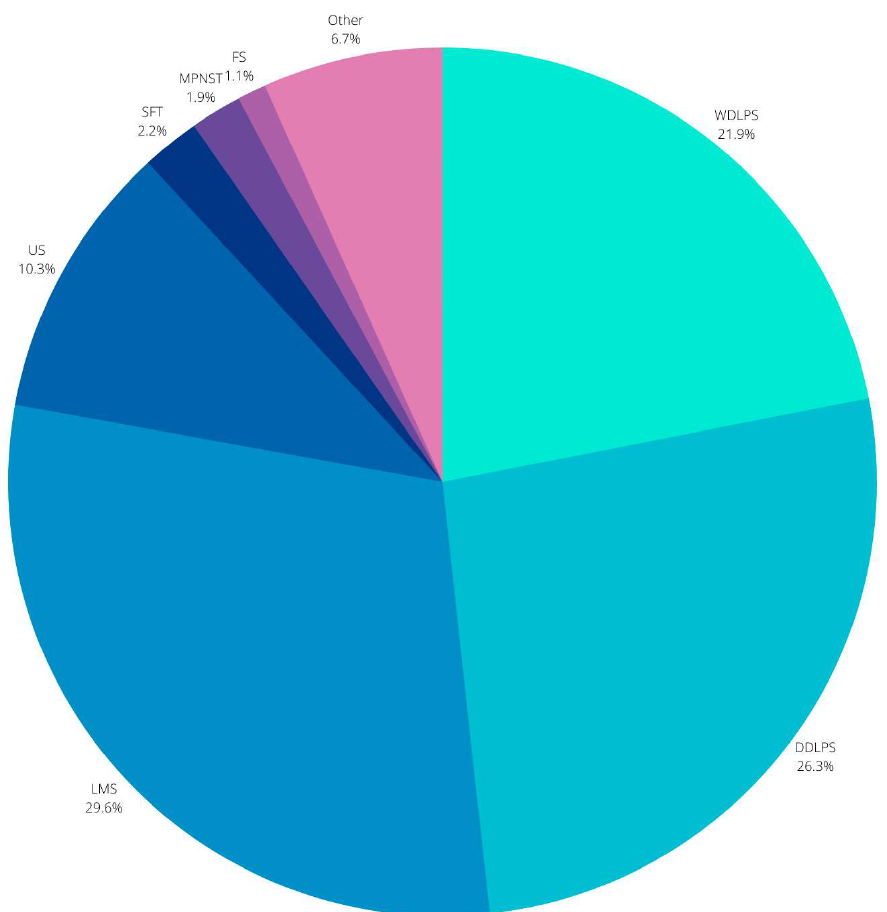
Figure 2. Diagram representation of the common subtypes of sarcoma within the retroperitoneum: DDLPS dedifferentiated liposarcoma; WDLPS well-differentiated liposarcoma, LMS leiomyosarcoma; US undifferentiated sarcoma; SFT solitary fibrous tumor, MPNST malignant peripheral nerve sheath, FS fibrosarcoma [9].